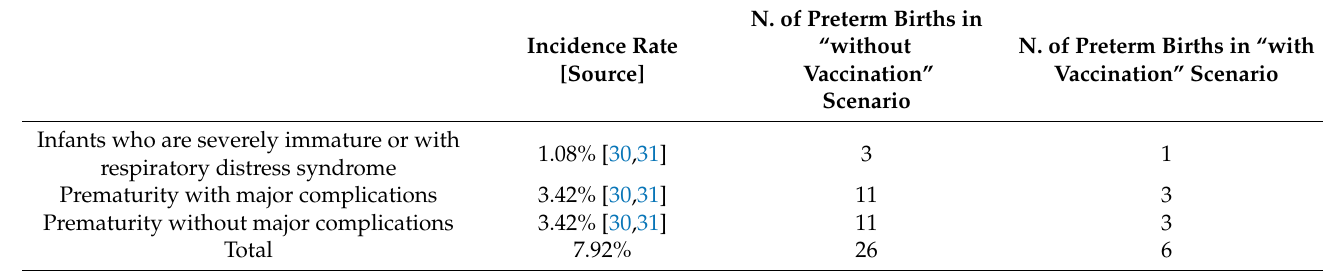
Table 8. Incidence rate of obstetric complications over the number of estimated pregnancies in women with CINs ( n =